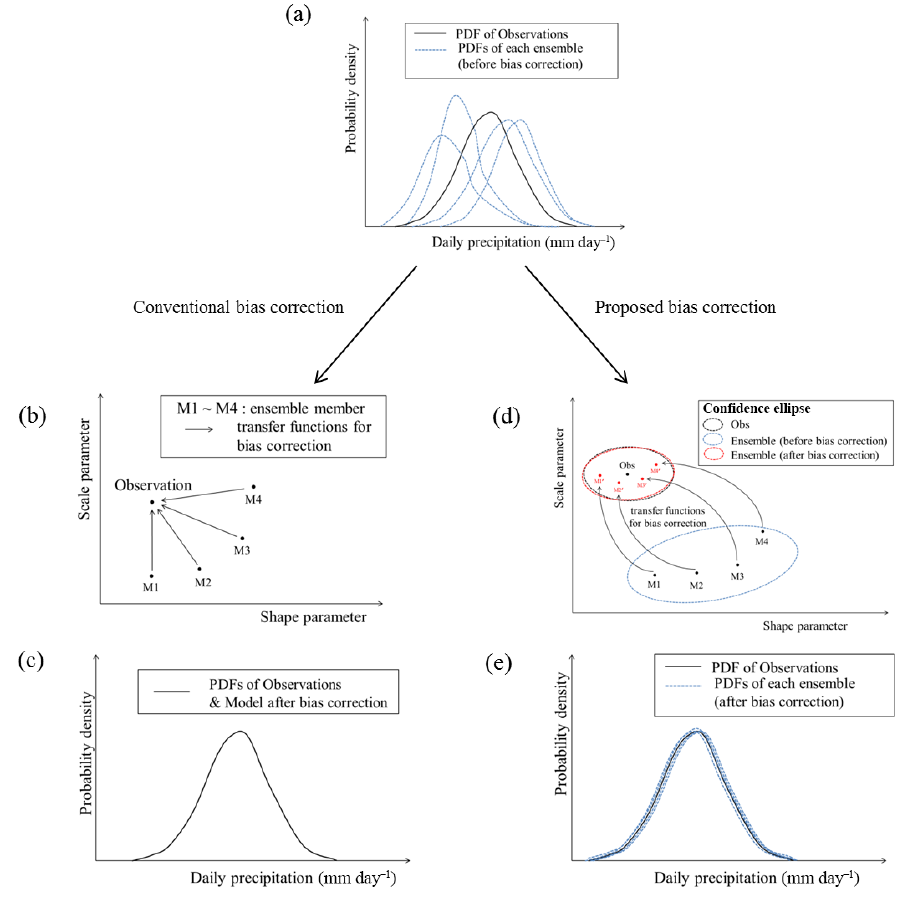
Figure 4. A schematic representation of the conventional bias correction method and the proposed bias correction